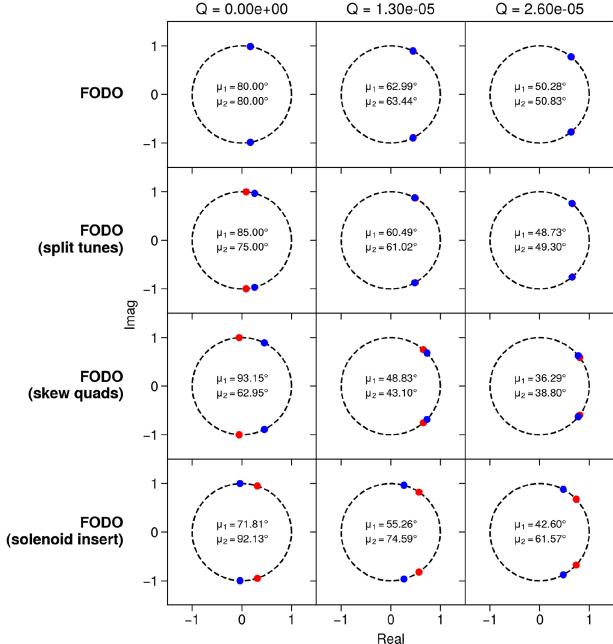
FIG. 13. Eigenvalues of the transfer matrix for the effective lattice related to the matched beam, plotted in the complex